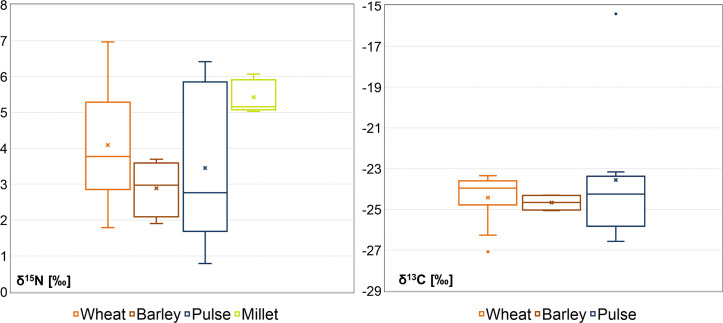
Box-plots showing the stable isotope results for wheat chaff and charred seeds.Corrected values have been used for a) δ15N results (-0.31‰ for the grains and +2.4‰ for the chaff to eliminate the charring effect) and b) δ13C results (-0.11‰ for the grains and +1.9‰ for the chaff). The boxes represent the first and third quartiles and the whiskers the maximum and minimum values, excluding the outliers. The continuous line illustrates the median and the cross represents the mean. For δ13C results only C3 plants are represented.